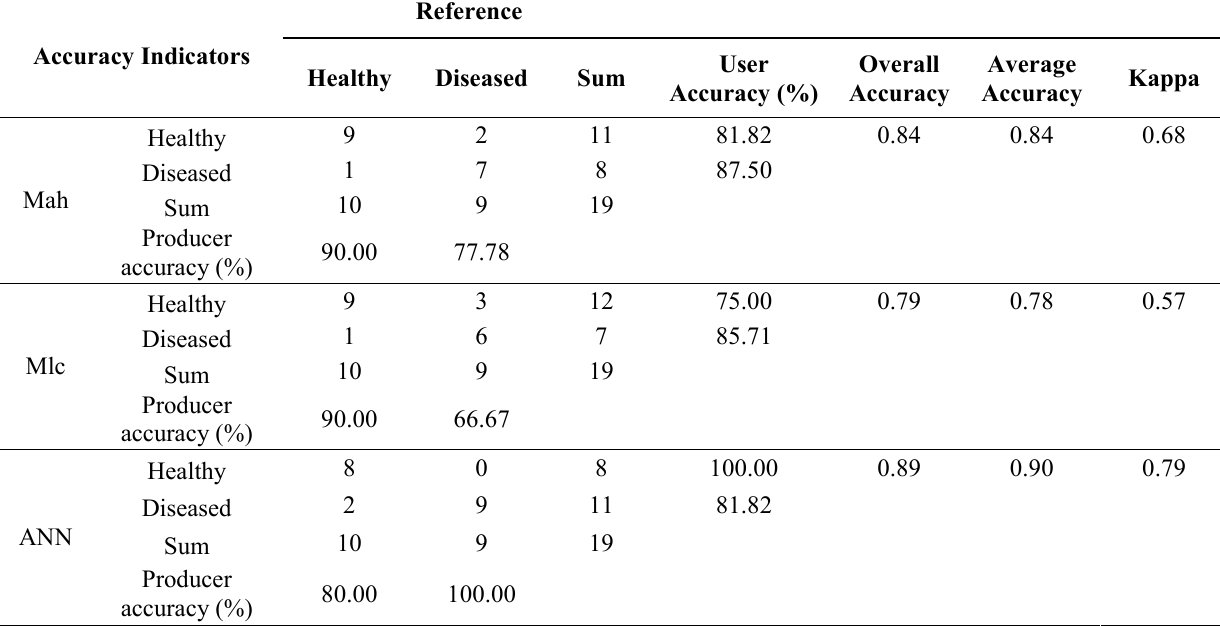
Table 6. Confusion matrices and classification accuracies of the three algorithms with test samples ( n =